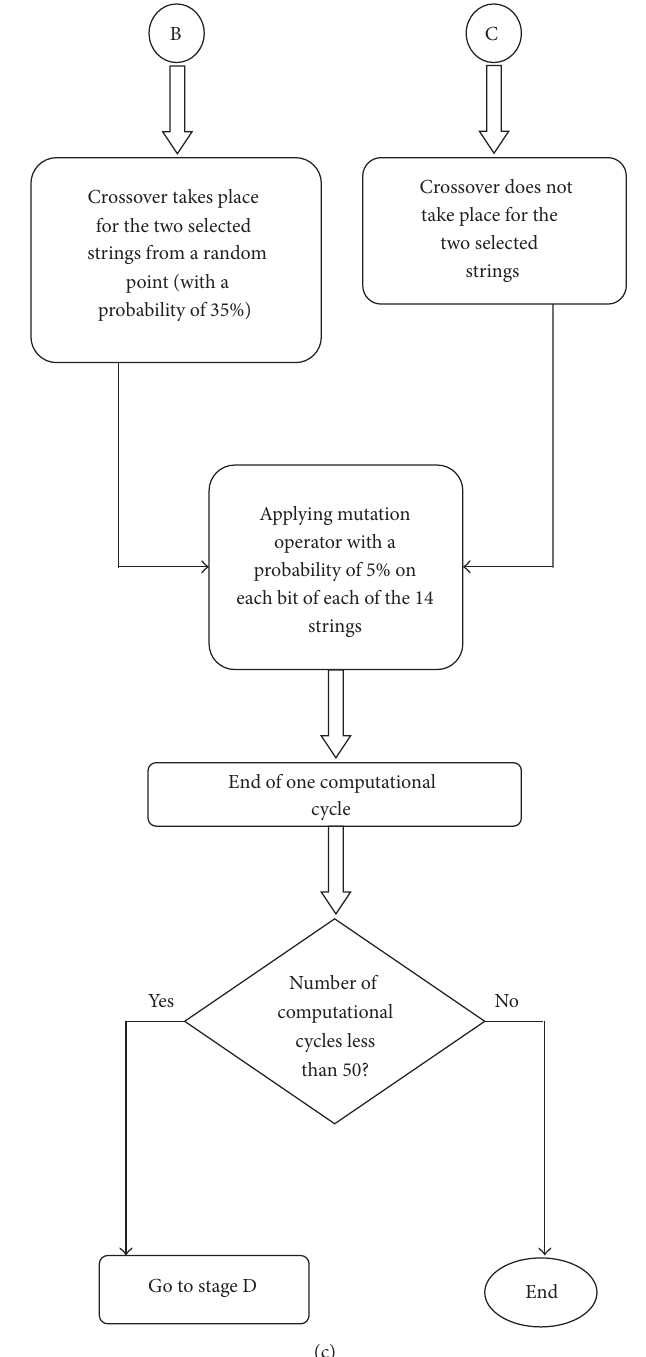
Figure 8: The algorithm of the written code for systematic inverse